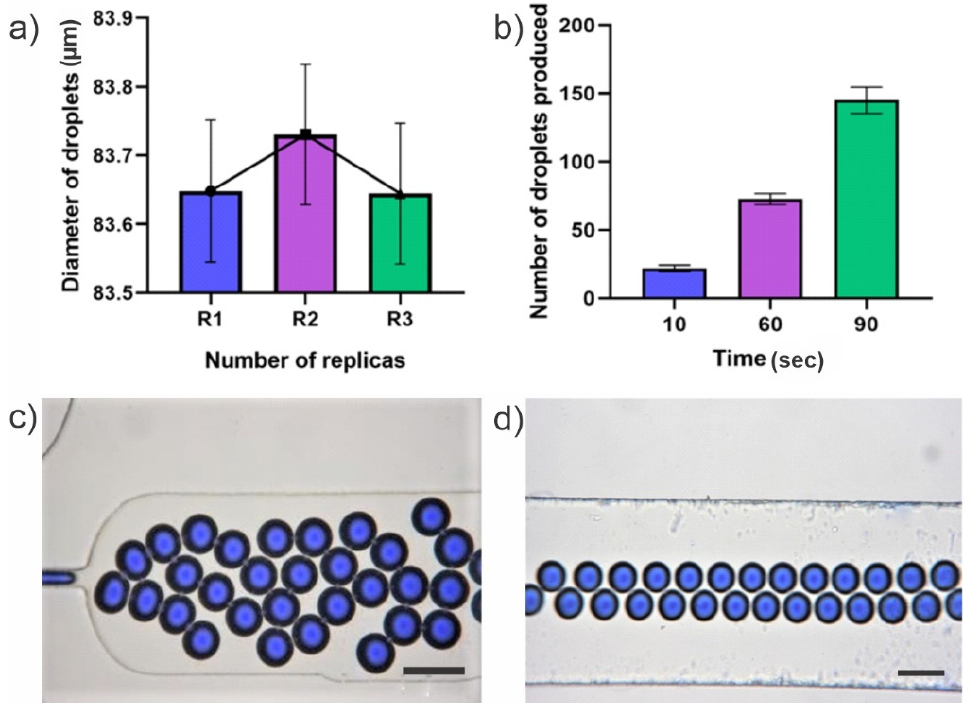
Figure 6. Droplet size and number of droplets produced. ( a ) Size of droplets produced after using the same microdevice three times (two reuses). ( b ) The average number of droplets produced in a time window measured in the output channel in the three assays of reuse. ( c ) Representative image of the droplets produced in the flow encounter model. ( d ) Representative image of the droplets produced in the outlet channel. Scale bar, 100 µm.